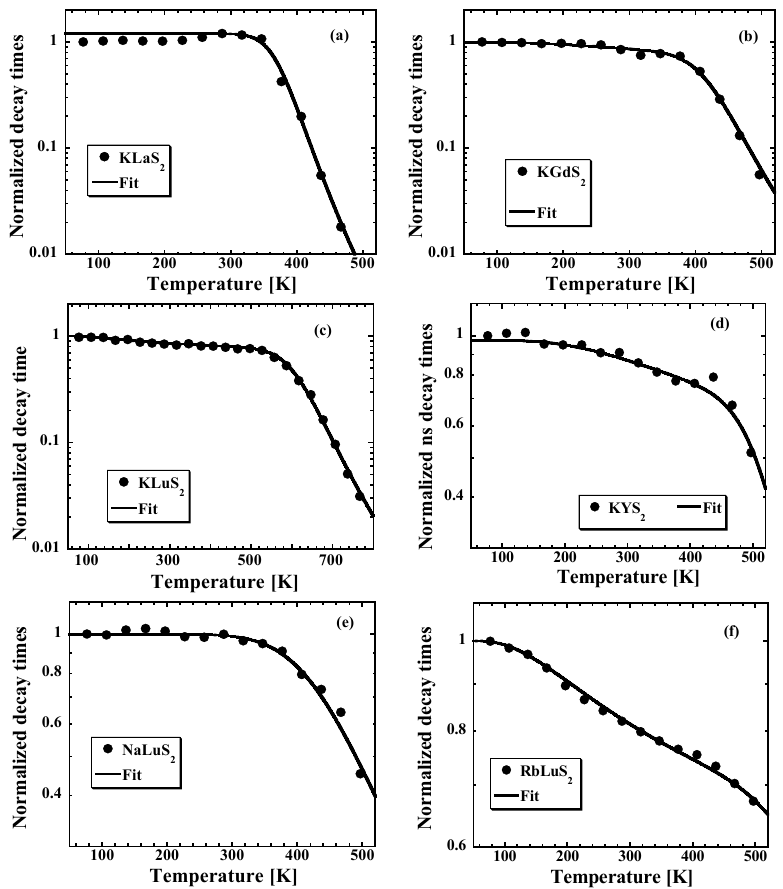
Figure 6. Temperature dependence of the emission (PL) decay times of Eu 2+ in ( a ) KLaS 2 ; ( b ) KGdS 2 ; ( c ) KLuS 2 after [16,27]; ( d ) KYS 2 ; ( e ) NaLuS 2 and ( f ) RbLuS 2 hosts; solid symbols are experimental data, solid lines are fits to the data using the phenomenological model described in the text. The parameters of fits are summarized in Table 4.